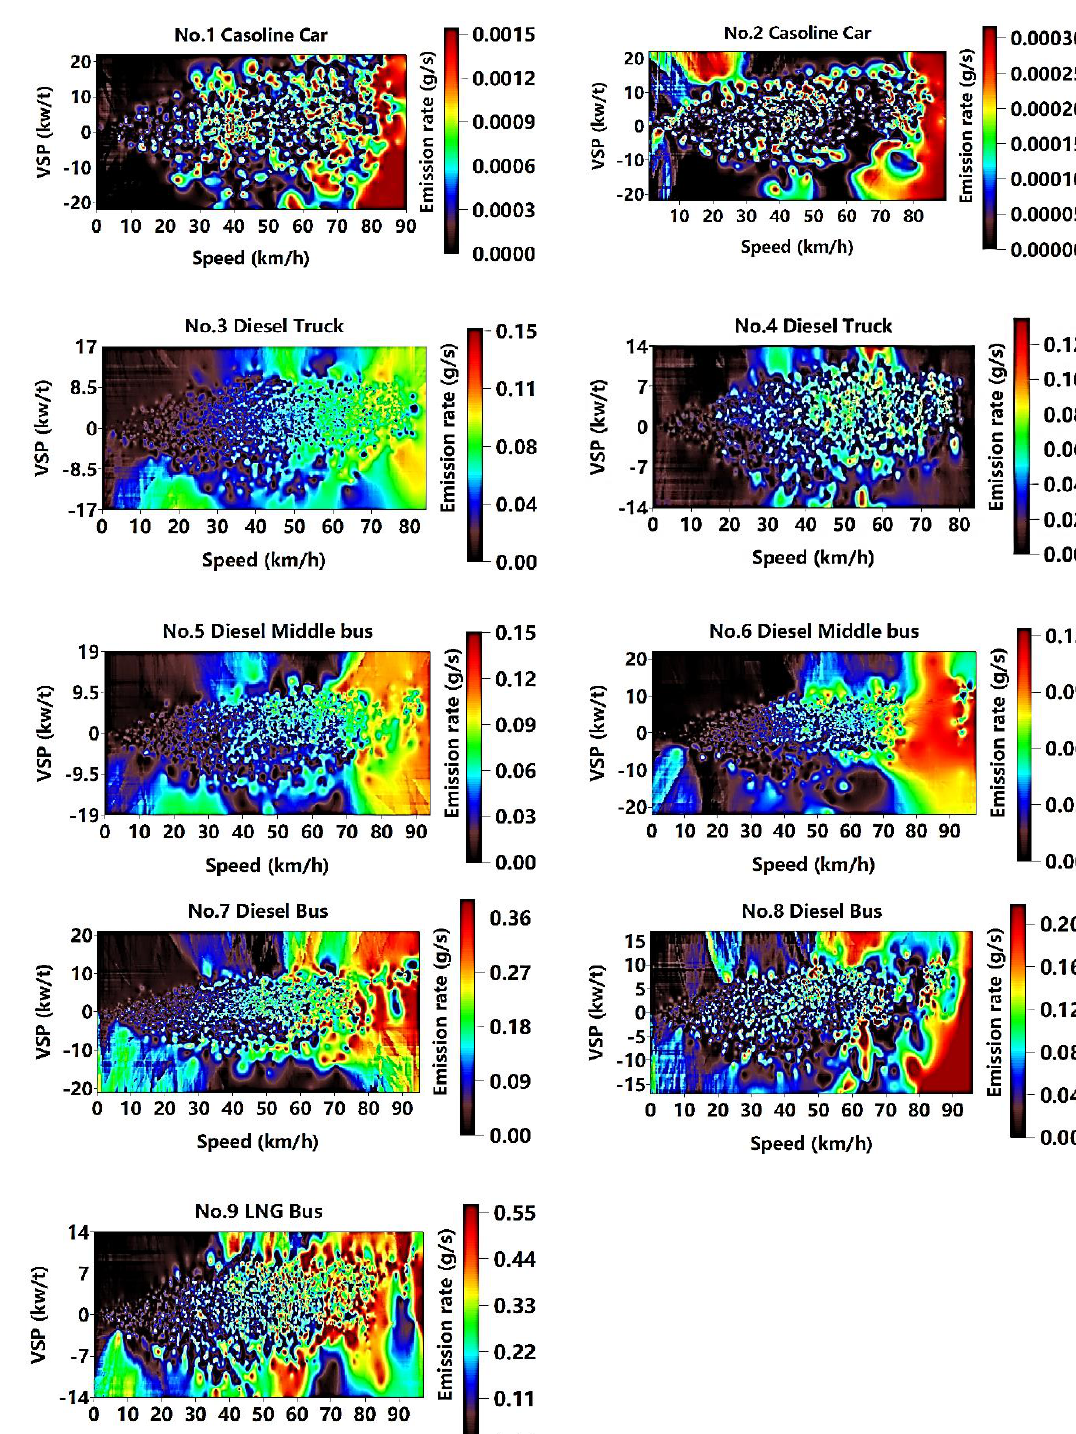
Figure 4. The image maps of the relationship between speed-VSP and NOx emission rates. NOx emission rates are represented by the colors. The black, brown, blue, cyan, green, yellow, orange, red, and ruby red areas indicate that the emission rates are approximately 0, 0.5, 1, 1.5, 2, 2.5, 3, 3.5, and over 4 times the average emission rate, respectively. Speed is at the X-axis, and VSP is at the Y-axis.